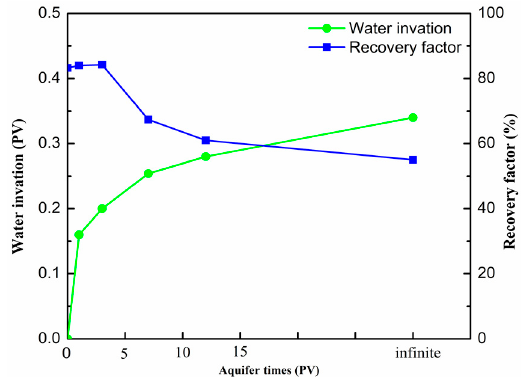
Figure 5. Water invasion and recovery factor versus aquifer times.